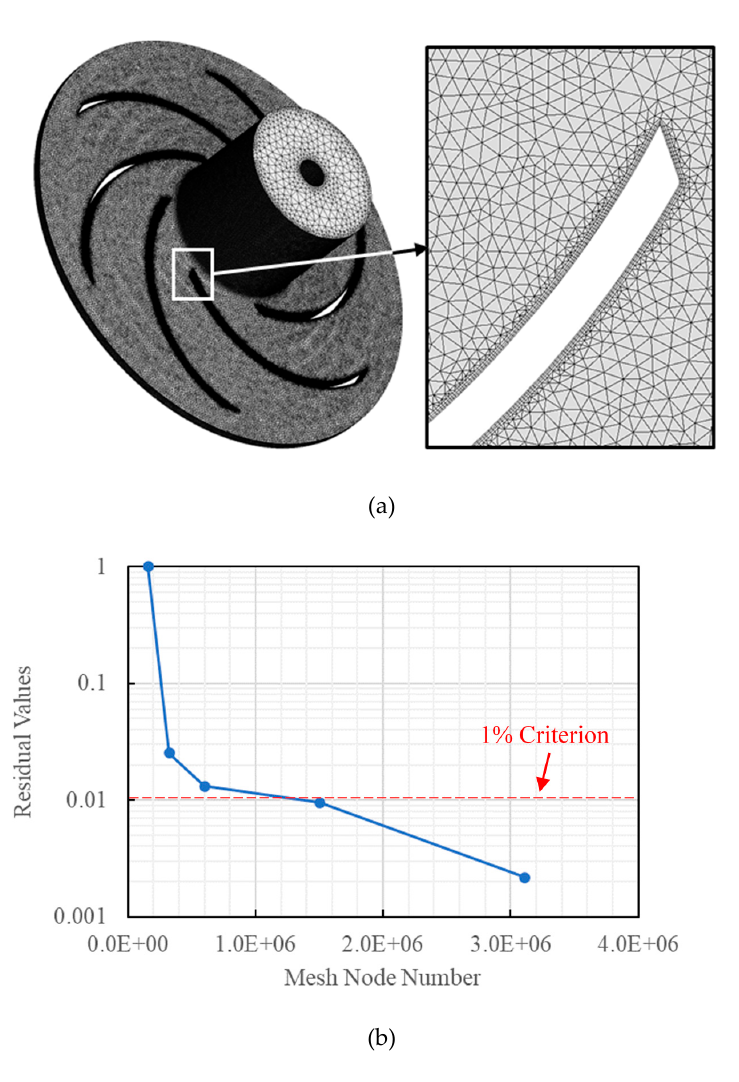
Figure 3. The schematic map of the mesh for computational fluid dynamics (CFD) simulation: ( a ) detailed view of mesh distributions; ( b ) variation of residual in the independence check.